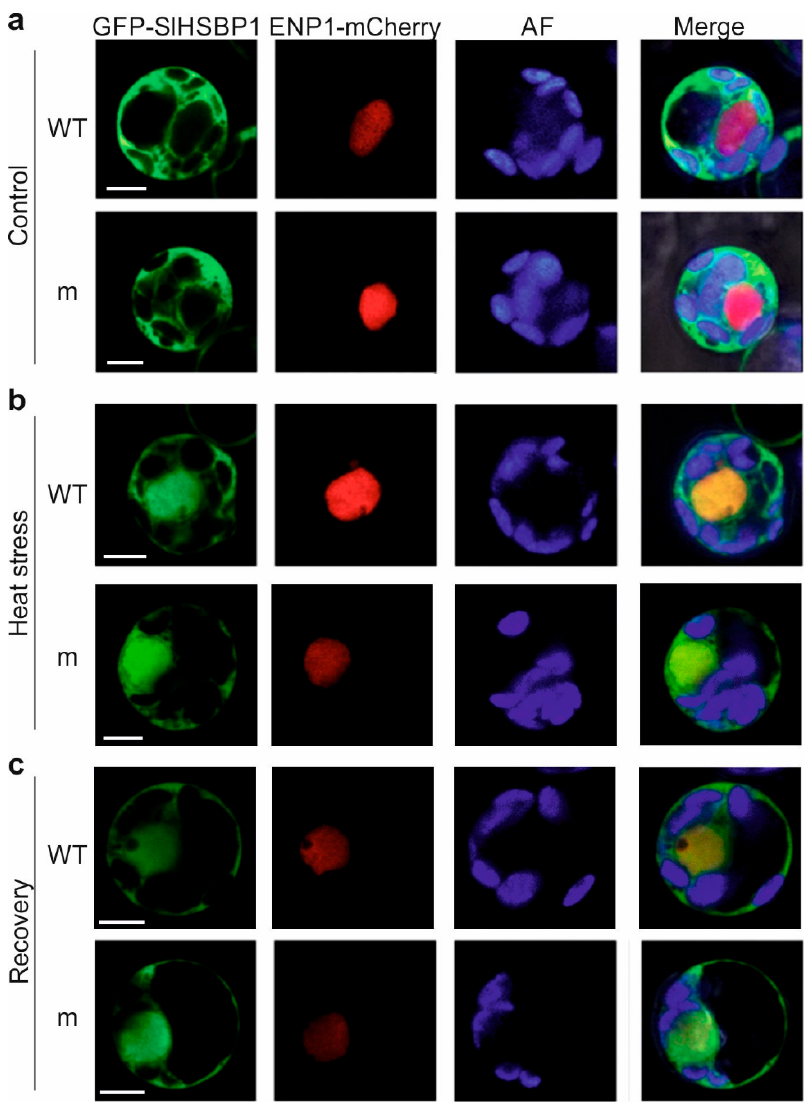
Figure 2. Subcellular localization of GFP-tagged HSBP1 (WT) and HSBP1m (m) proteins ( a ) before (control) and ( b ) after heat stress, or ( c ) during the recovery phase. Protoplasts were either kept at 25 °C or exposed to 40 °C for 1 hour (heat stress), and then allowed to recover for 1.5 hours at 25 °C. AF: chlorophyll autofluorescence. ENP1-mCherry is a nuclear marker protein. Scale bars are 5 μ m.